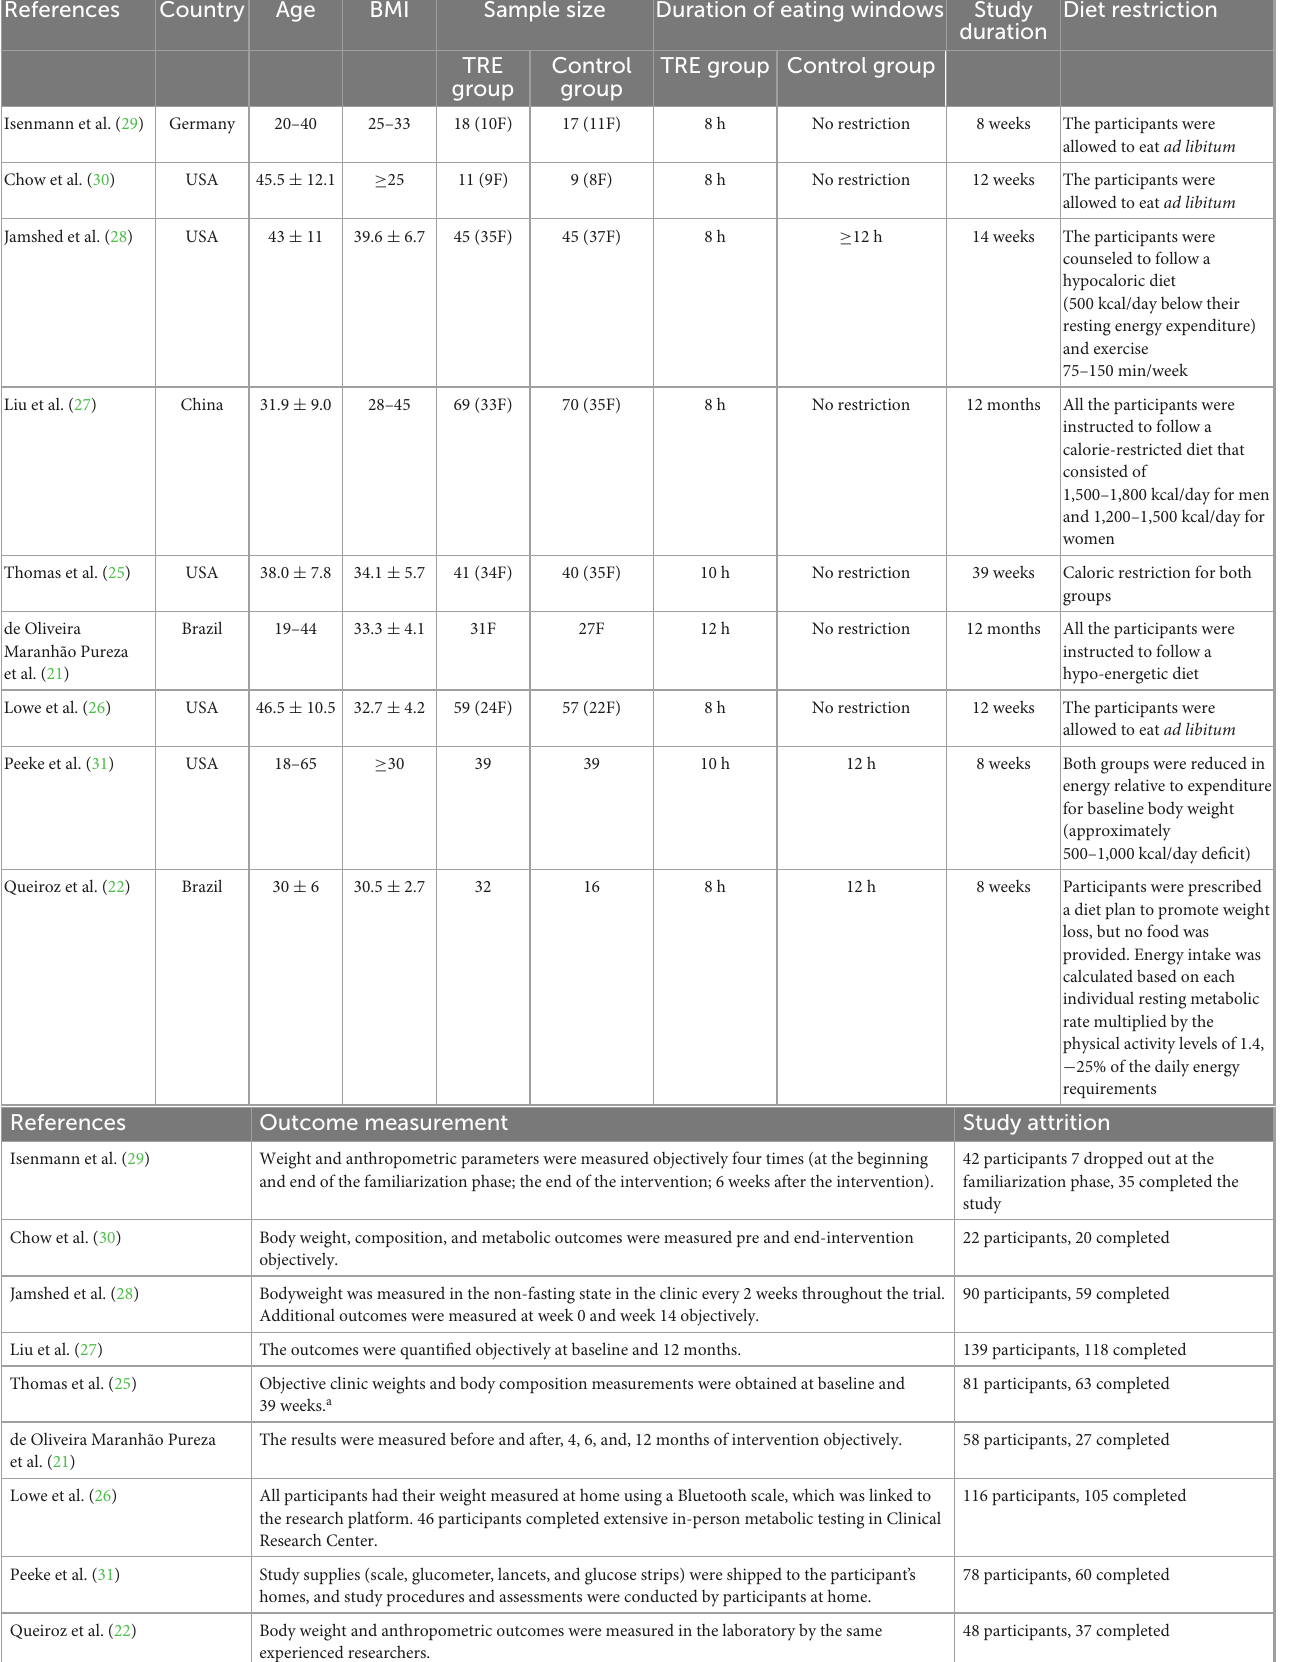
TABLE 1 General features of the nine included